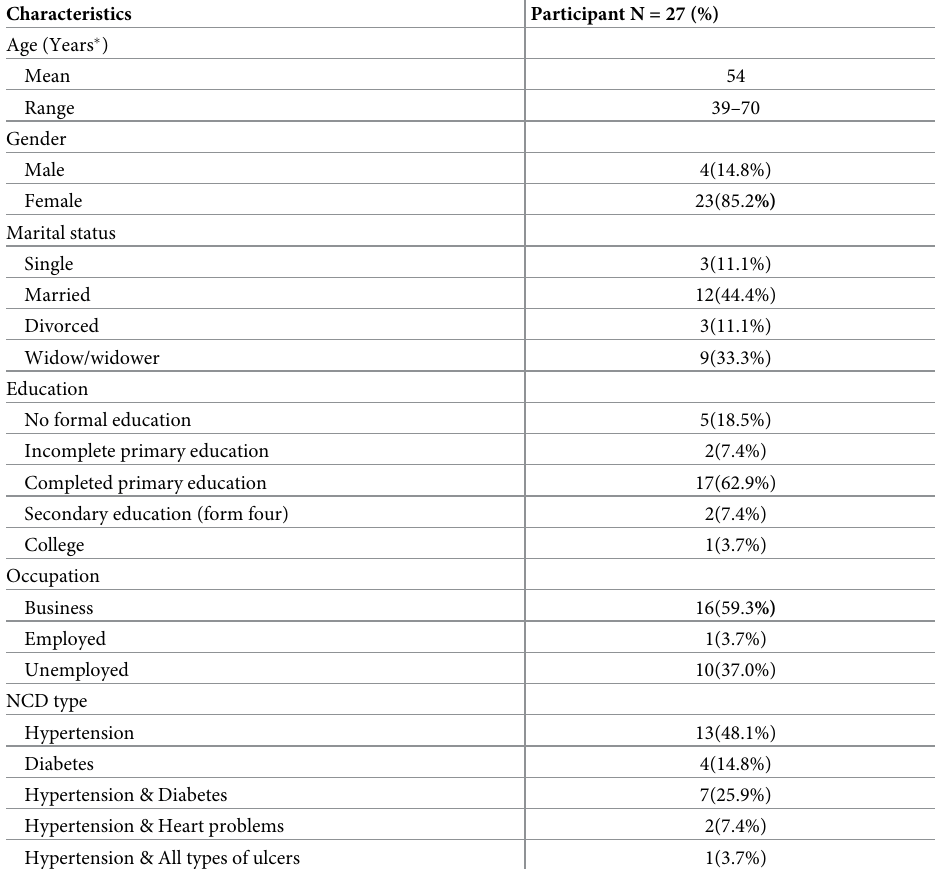
Table 2. Demographic characteristics of people living with HIV/AIDS (PLHA) and NCD comorbidity accessing HIV care and treatment clinic services in 2020, Dar es Salaam, Tanzania (N = 27).